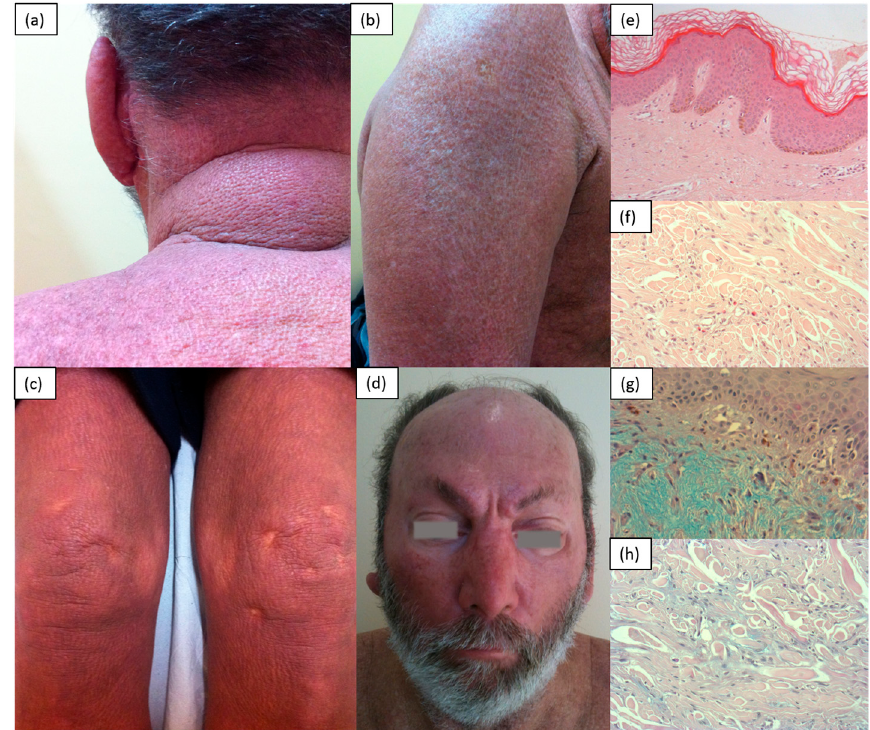
Figure 4. A 65-year-old male patient with IgGk monoclonal gammopathy. Presence of confluent erythematous brown papules distributed on the back ( a ) and extensor surfaces of the limbs ( b , c ). Leonine facies caused by mucin deposition in the forehead and glabella ( d ). H&E (original magnification: 50×)—epidermis and full-thickness dermis ( e ); H&E (original magnification: 200×)—wide magnification with evidence of a significant number of eosinophils ( f ); Alcian–Pas (original magnification: 200×)—superficial dermis with dermal mucinosis (accumulation of acid mucopolysaccharides (light blue in the photo)), mainly in the superficial dermis ( g ) and between the collagen bands ( h ).